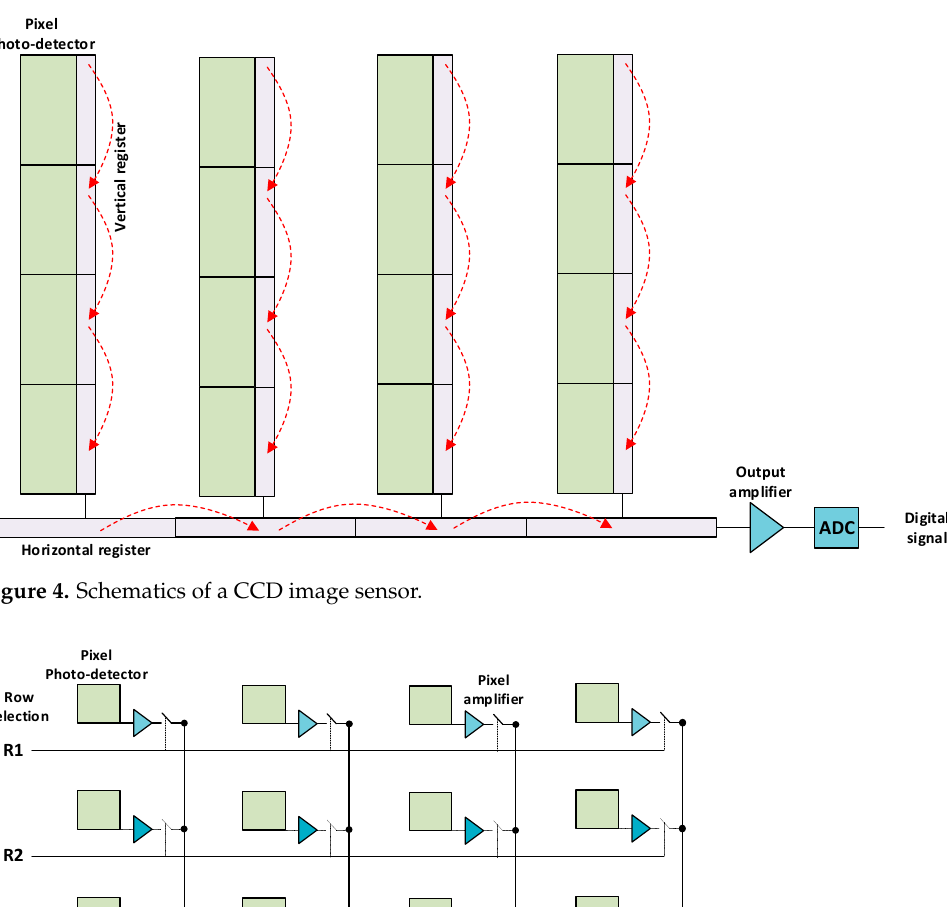
Figure 5. Schematics of a CMOS image sensor. Front-Illuminated versus Back-Illuminated Image Sensors